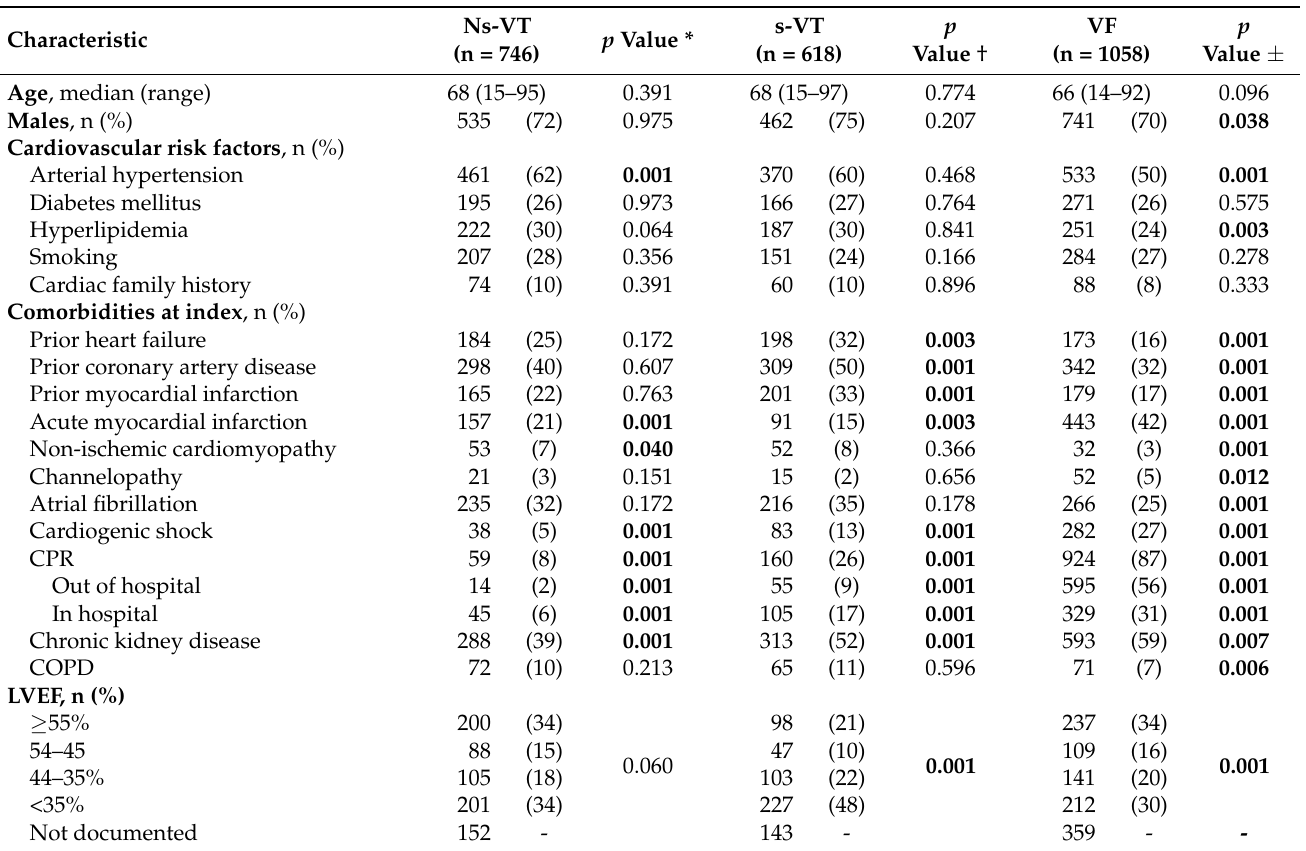
Table 1. Baseline characteristics of the entire study cohort.